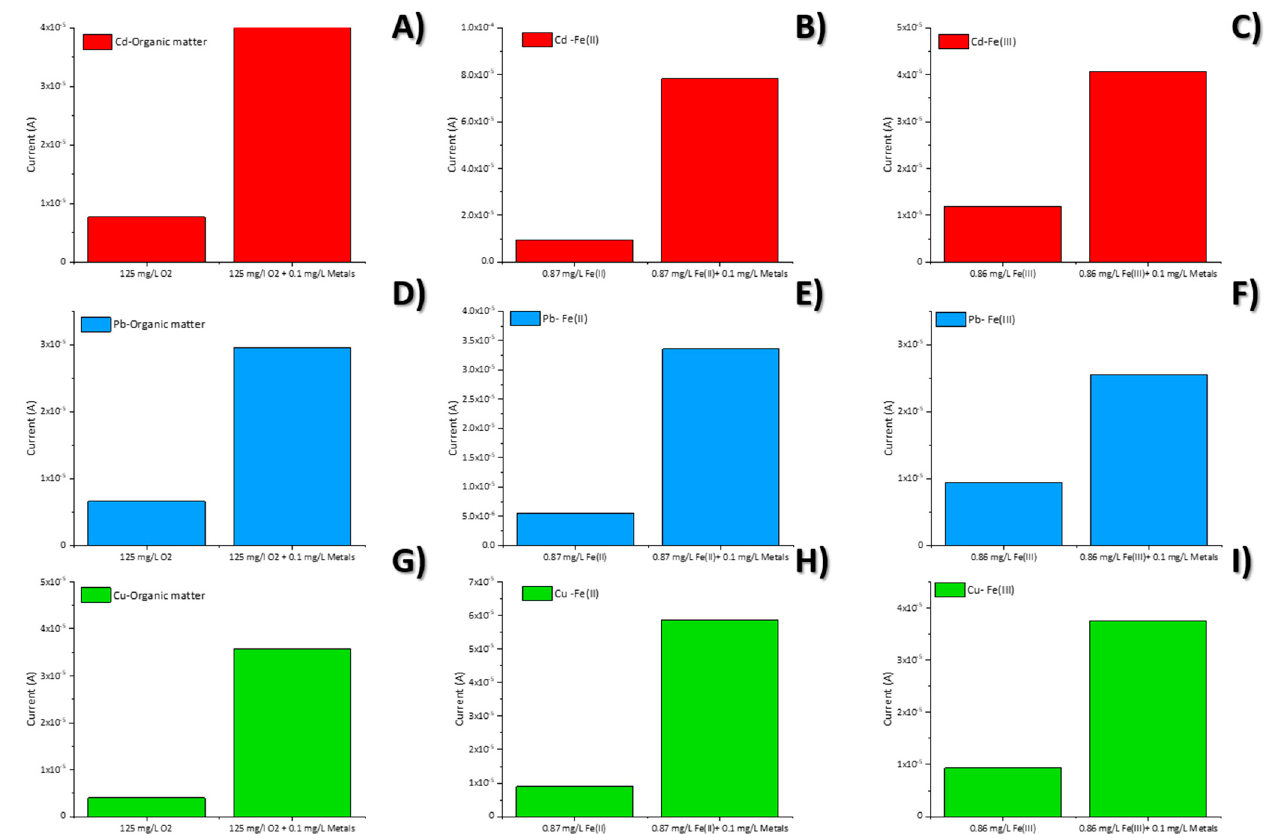
Figure 5. Summary of the currents obtained for the maximum concentrations of interference evaluated in the presence or not of the analyte: ( A ) 0.11 mg · L − 1 Cd 2+ -125 mg · L − 1 O 2 ; ( B ) 0.11 mg · L − 1 Cd 2+ -0.87 mg · L − 1 Fe(II); ( C ) 0.11 mg · L − 1 Cd 2+ -0.86 mg · L − 1 Fe(III); ( D ) 0.09 mg · L − 1 Pb 2+ -125 mg · L − 1 O 2 ; ( E ) 0.09 mg · L − 1 Pb 2+ -0.87 mg · L − 1 Fe(II); ( F ) 0.09 mg · L − 1 Pb 2+ -0.86 mg · L − 1 Fe(III); ( G ) 0.08 mg · L −